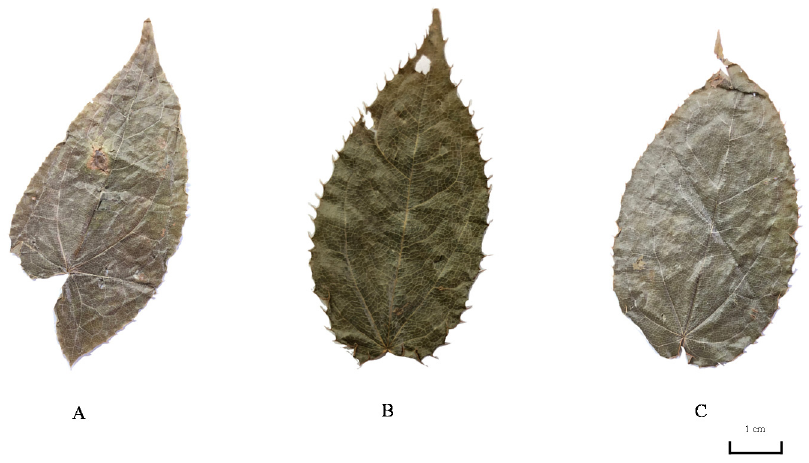
Figure 5. The dried leaves of ESa ( A ), Eko ( B ) and EPu ( C